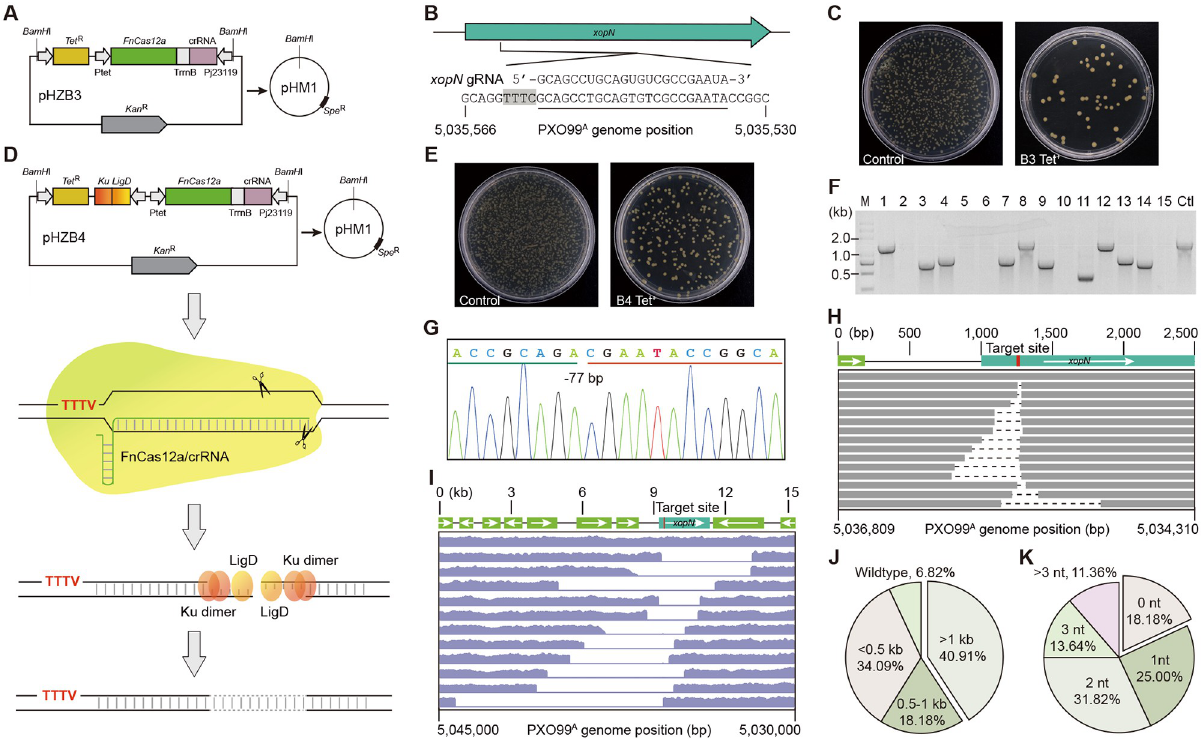
Fig 1. CRISPR/FnCas12a-mediated genome editing in Xoo PXO99 A . (A) Schematic illustration of pHM1B3 CRISPR cassette construction. The intermediate CRISPR construct pHZB3 is released through BamH I digestion and integrated into the vector pHM1. Tet R , tetracycline resistance gene; Ptet, tetracycline-inducible promoter; FnCas12a, the CRISPR/Cas12a system from F . novicida ; TrrnB, E . coli ribosomal RNA terminator rrnB; crRNA, a matured CRISPR RNA; Pj23119, a synthetic constitutive expression promoter; Kan R , kanamycin resistance gene; pHM1, a broad-host-range vector; Spe R , spectinomycin resistance gene. (B) The target site of xopN . The target region in PXO99 A genome is underlined and the PAM sequence is marked by the black shadow. (C) Electroporated PXO99 A on agar plates. Under the same conditions, except that the control (left plate) did not contain protospacer of xopN . (D) Schematic illustration of pHM1B4 CRISPR cassette construction. It’s updated from (A) with a single operon encoding mtLigD and mtKu proteins, which reconstitute a simplified non-homologous end joining (NHEJ) machine for DSB repair in Xoo cells. (E) As for (C) , but showing the genome editing system of pHM1B4. (F) Single colonies in (E) were randomly selected for preliminary identification by PCR amplification of a 1.3-kb genomic fragment flanking the xopN gene. M, 5 kb DNA ladder; Ctl, wild-type control. (G) Representative Sanger sequencing chromatogram of the deletion mutant. -77 bp, 77-bp deletion. (H) The deletion size distribution of independent mutant strains was determined by tiling PCR and Sanger sequencing. The first line is wild type, other lines represent independent mutants, the dash lines indicate the deleted region in each mutant, and the target site location is marked in red. (I) As for ( H ), but determined by the whole-genome sequencing (WGS) analysis of 11 PXO99 A mutants. (J) The pie chart represents the proportion of different bidirectional deletion ranges. (n = 44 individual colonies randomly selected from (E) ). (K) As for (J) , but depicting the ratio of the different flanking micro-homology regions used for DSB